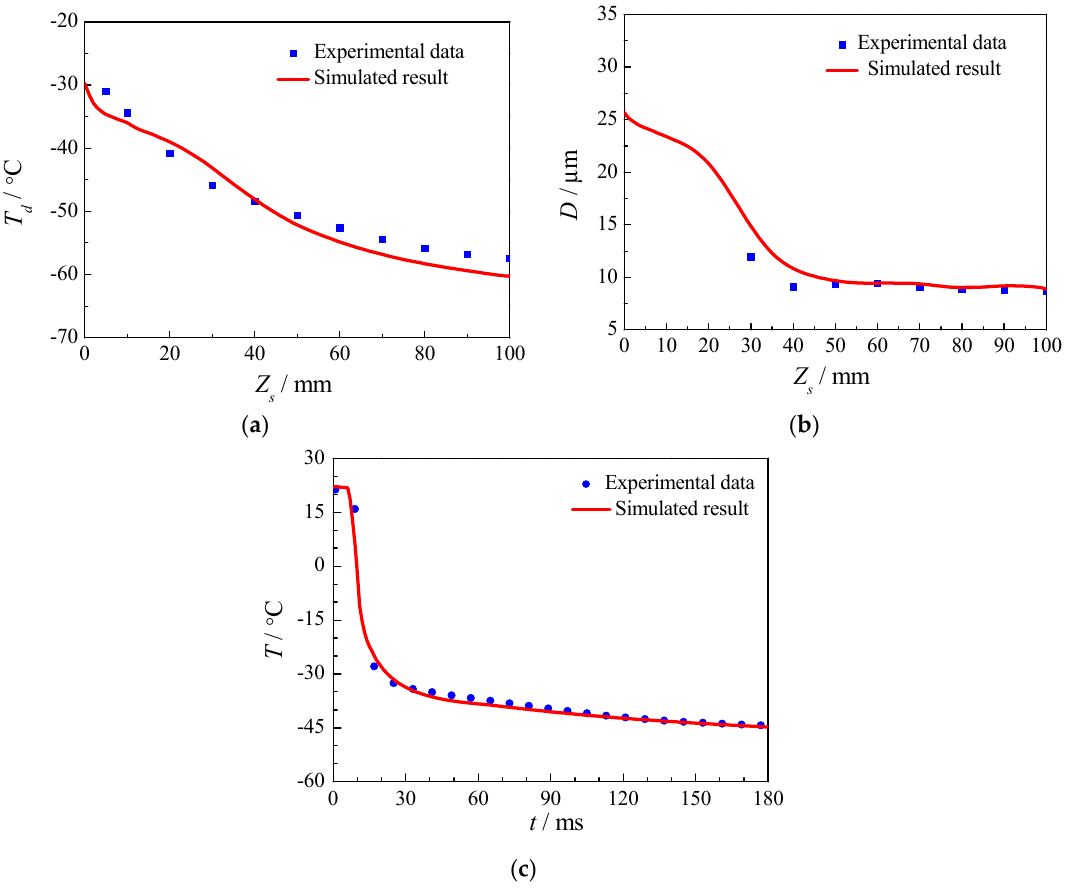
Figure 8. Comparison of ( a ) droplet temperature, ( b ) diameter and ( c ) surface temperature of skin tissue in the experiment [40] and simulation.